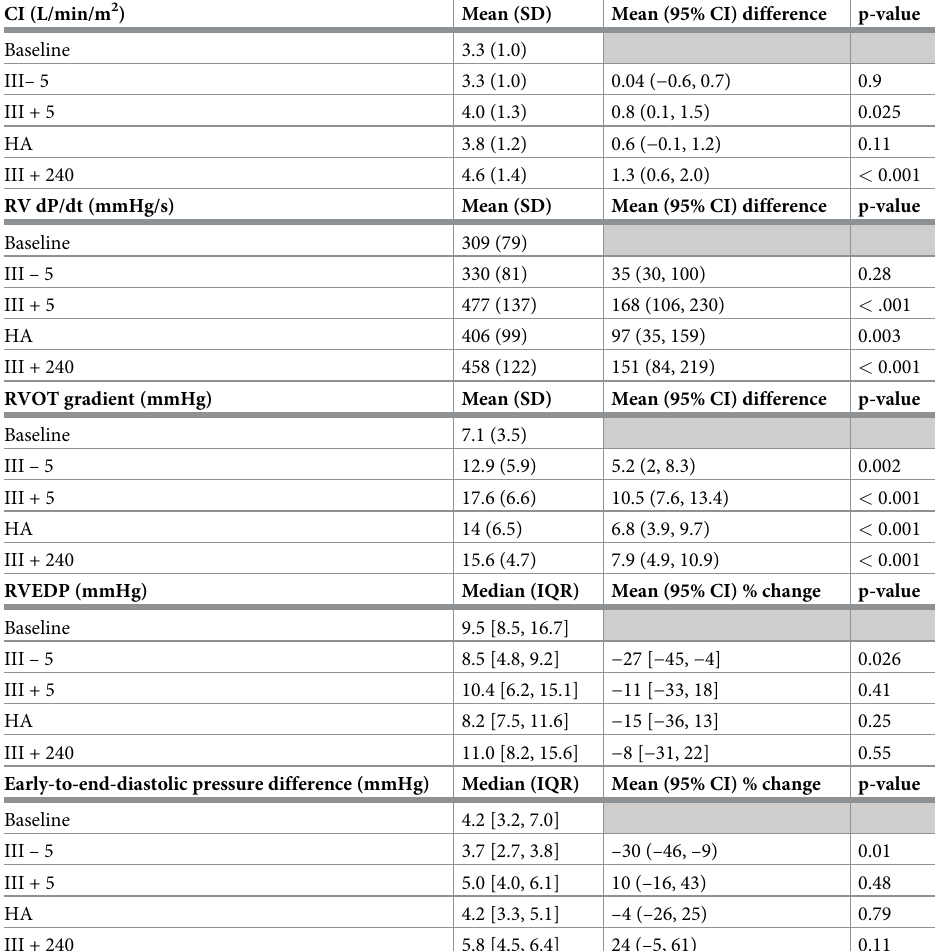
Table 3. Differences in waveform metrics at each study time point.